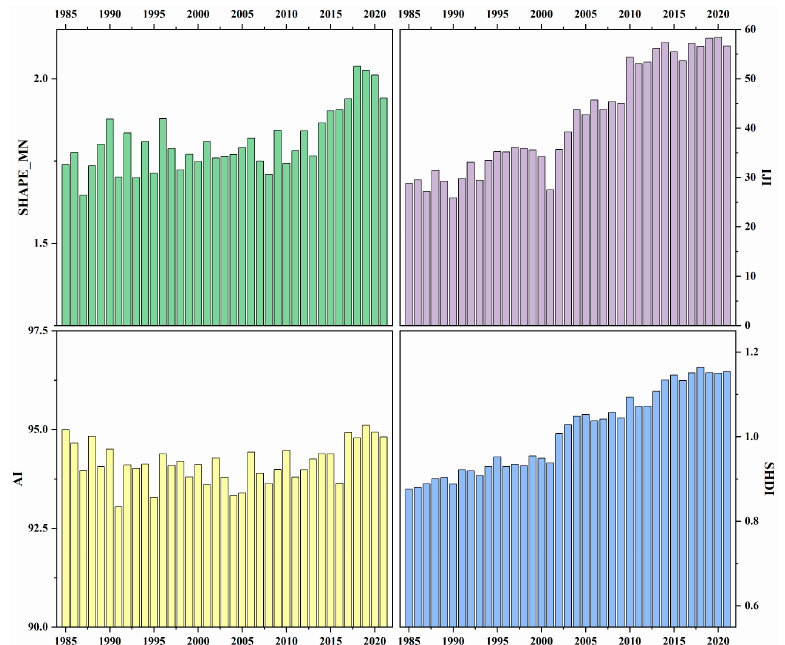
Figure 8. Changes in four landscape-level indices in the HNNR from 1985 to 2021.